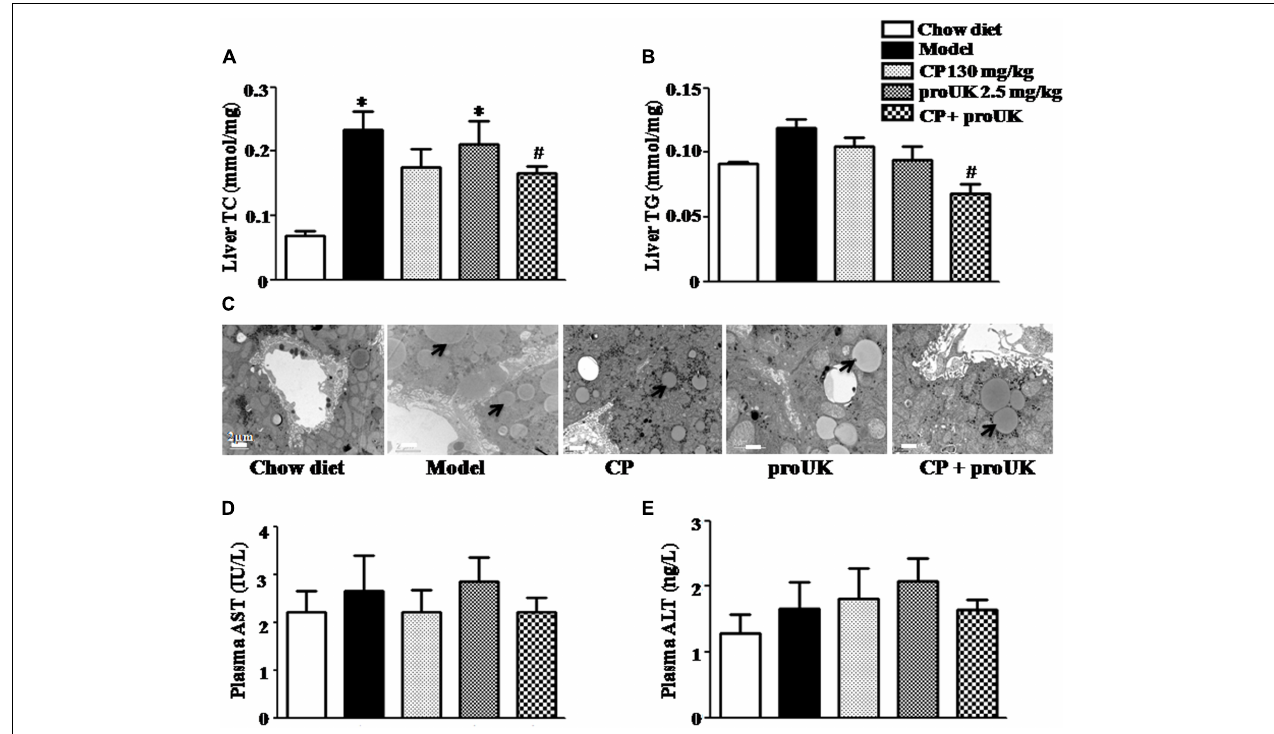
FIGURE 4 | CP plus proUK attenuates hepatic lipid deposition and increase in TC and TG while does not affect liver function in high fat diet-fed LDLR − / − mice. (A) Hepatic TG levels in different groups. (B) Hepatic TC levels in different groups. (C) Transmission electron microscopic images of the sinusoids in different groups. Bar = 2 µ m. (D) AST activity in plasma from different groups. (E) ALT activity in plasma from different group. Data are mean ± SEM ( n = 8). The arrow shows the lipid droplet. ∗ P < 0.05 vs. Chow diet mice, # P < 0.05 vs. Model mice.